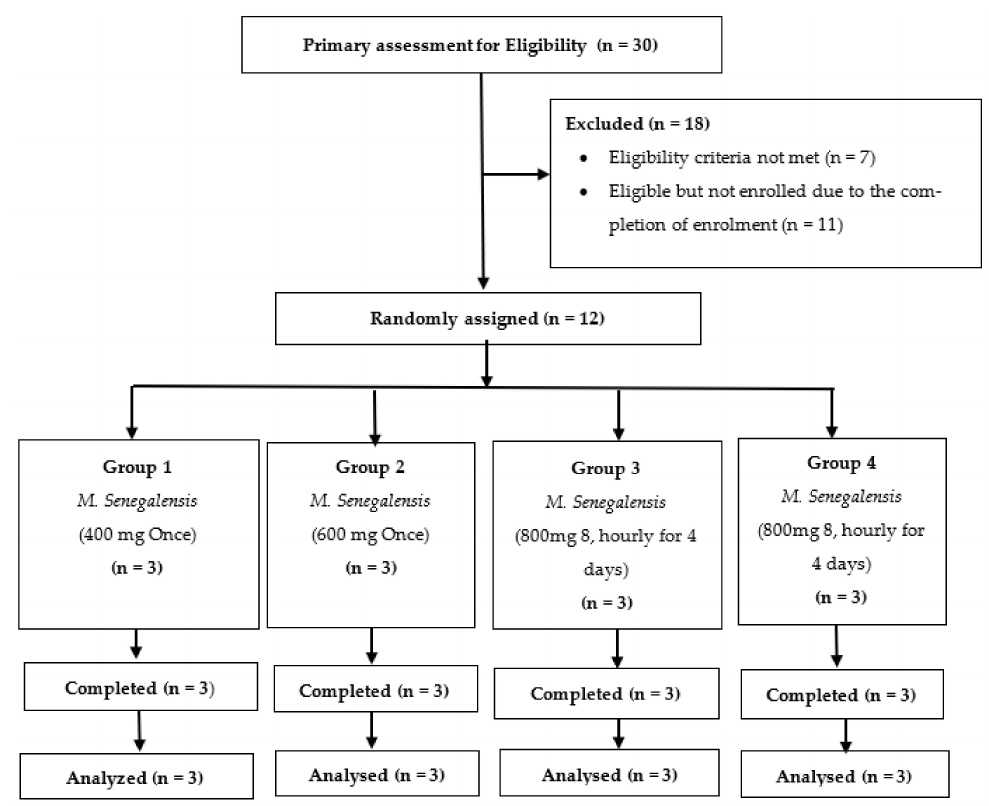
Figure 4. Trial flow chart showing volunteer